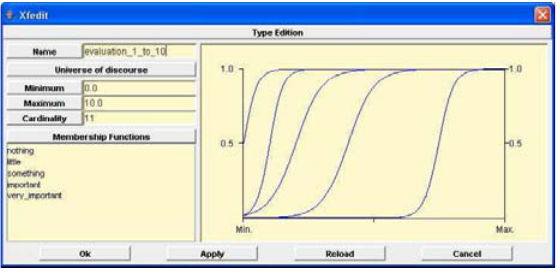
Fig. 7: Variable evaluation with values between 0 and